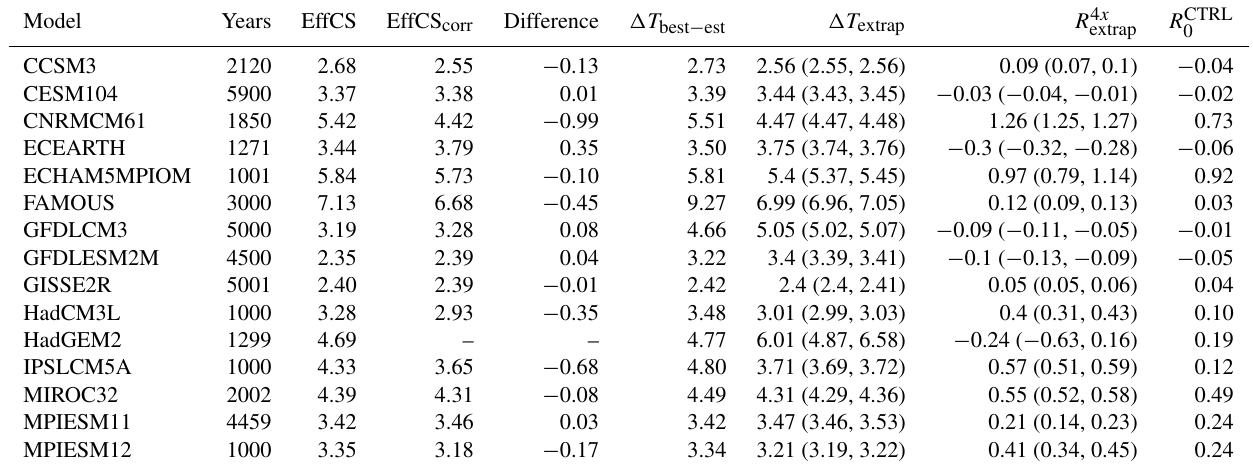
Table 4. Fitted parameters and uncertainties for the LongRunMIP experiments. Median values, with 5th and 95th percentiles in brackets where relevant. The “Difference” column shows EffCS corr − EffCS. EffCS corr is not calculated for HadGEM2 due to large uncertainties in R 4 x extrap